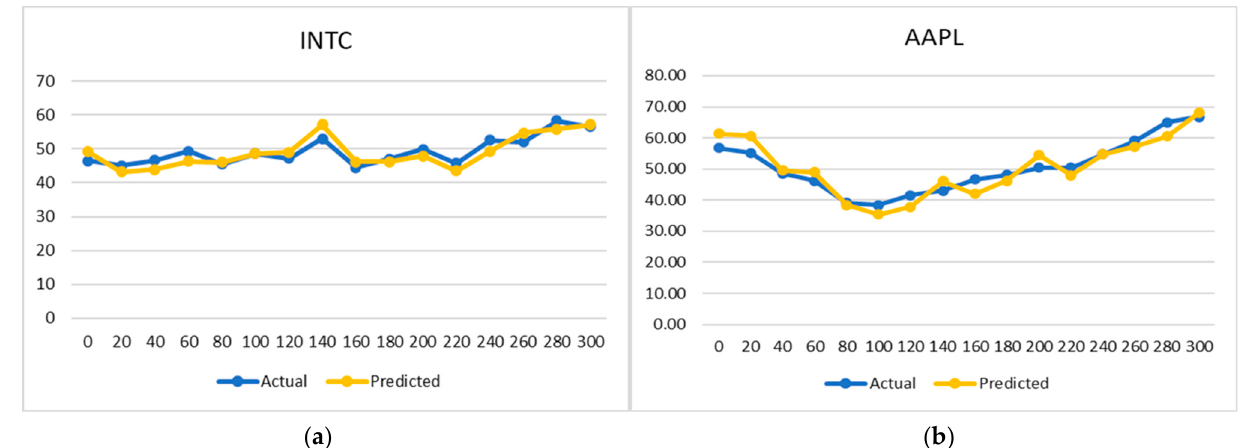
Figure 6. Actual and predicted price graph for ( a ) INTC and ( b ) AAPL.